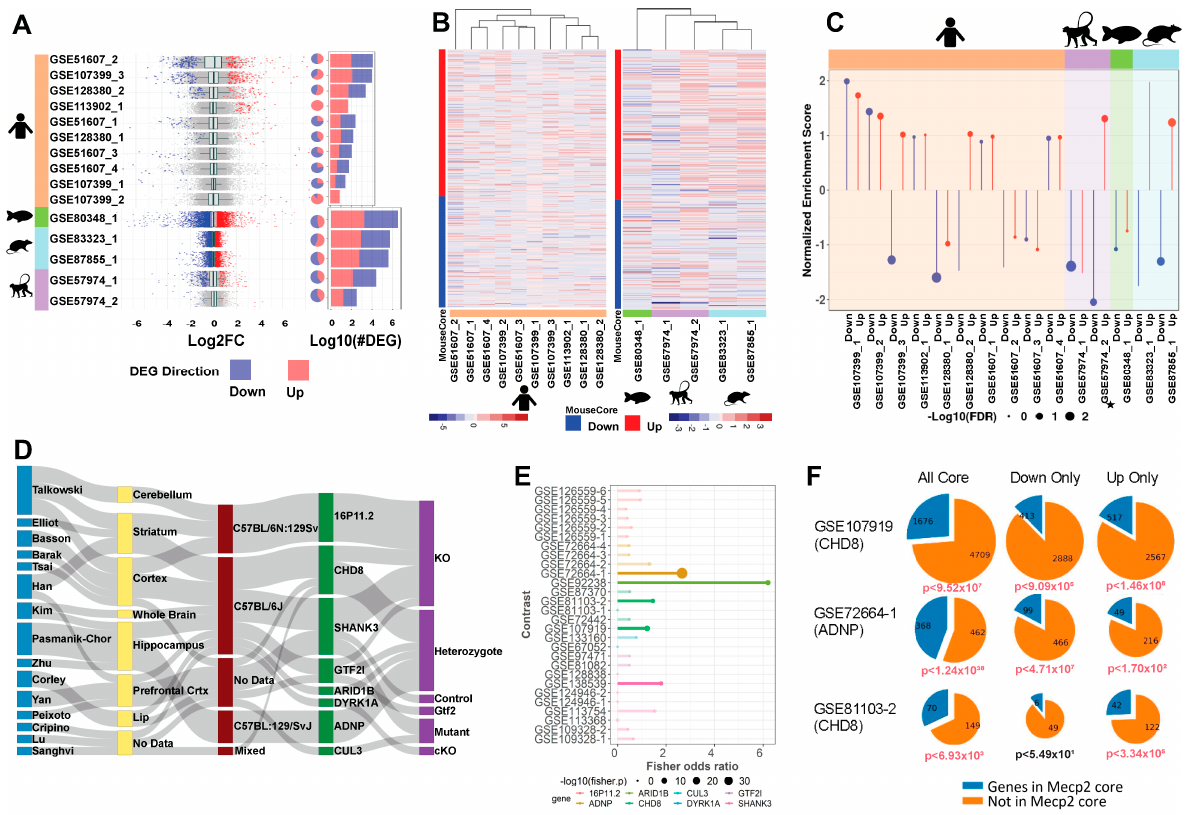
Figure 4. Mouse transcriptome translation to other models. ( A ). Distribution of log2 fold change across contrasts with significant (FDR < 0.01) DEGs. Blue and red, respectively, indicate down and up DEGs. Pie charts with the same annotation coloring show the percentage of each contrast’s DEGs in each category. Stacked bar charts with the same annotation color show each contrasts’ DEG quantity. The upper 7 contrasts are human data, and the lower 5 are other species. ( B ). Heatmaps of log2 fold change plotted to compare direction of dysregulation to the consensus from mouse data. Genes examined are the mouse common core, and plots are annotated on mouse core down and mouse core up. ( C ). Per-contrast visualization of GSEA normalized enrichment score and FDR. Direction and color of line represents normalized enrichment score, and point size represents log10(FDR). Contrasts are grouped and shaded corresponding to their model of origin. MDS model is annotated with a small star. ( D ). Sankey plot of ASD contrast metadata characteristics. From left to right: first author, tissue, strain, target gene, and experimental procedure. ( E ). Fisher’s exact test results. Points sized by –log10( p -value), length determined by odds ratio, data colored by gene. Points are opaque, and overlap to MeCP2 core is considered significant if the Fisher p -value is less than 0.05. ( F ). Pie charts show the magnitude of overlap between selected ASD contrasts and the MeCP2 common core. Down and up only show genes changed in the same direction in both sets. p -values beneath each plot show the Fisher’s exact test significance of the overlap for each intersection, colored red if the p -value is less than 0.05.